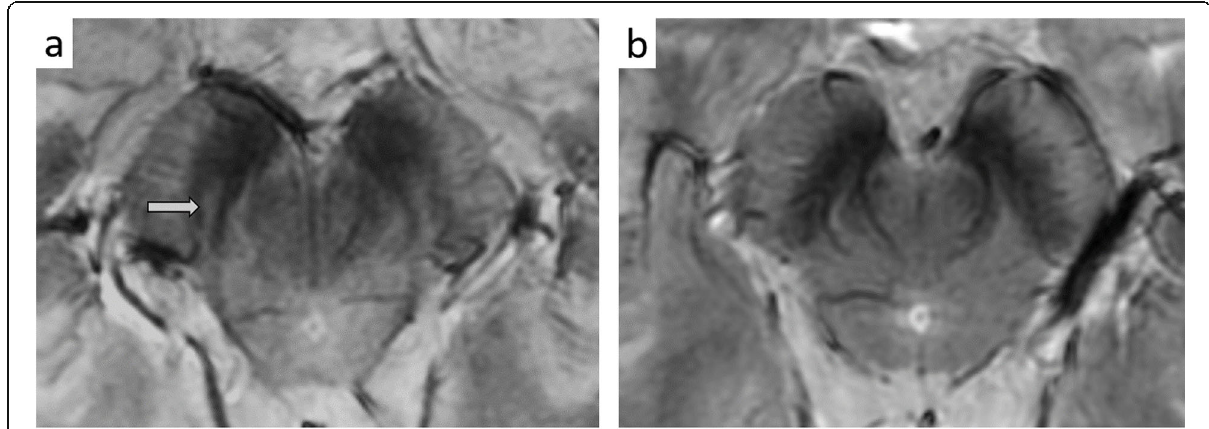
Fig. 3 3D multi-echo T2*-weighted images of the substantia nigra at the level of the nigrosome 1 (arrow) in a an RBD patient with a normal imaging of the substantia nigra who has not developed symptoms or signs of parkinsonism in the follow-up; b an RBD patient with abnormal findings at imaging (the nigrosome 1 was not visible), who eventually converted to